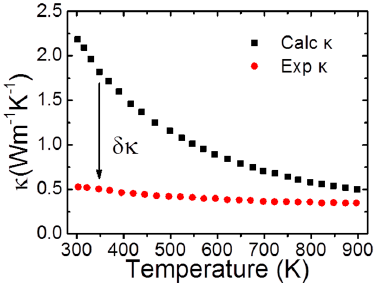
Figure 1. Calculated thermal conductivity. The black squares represent the calculated total thermal conductivity, and the red circles represent the experimental data. Reproduced with permission from Reference [57]. Copyright 2015, IOP